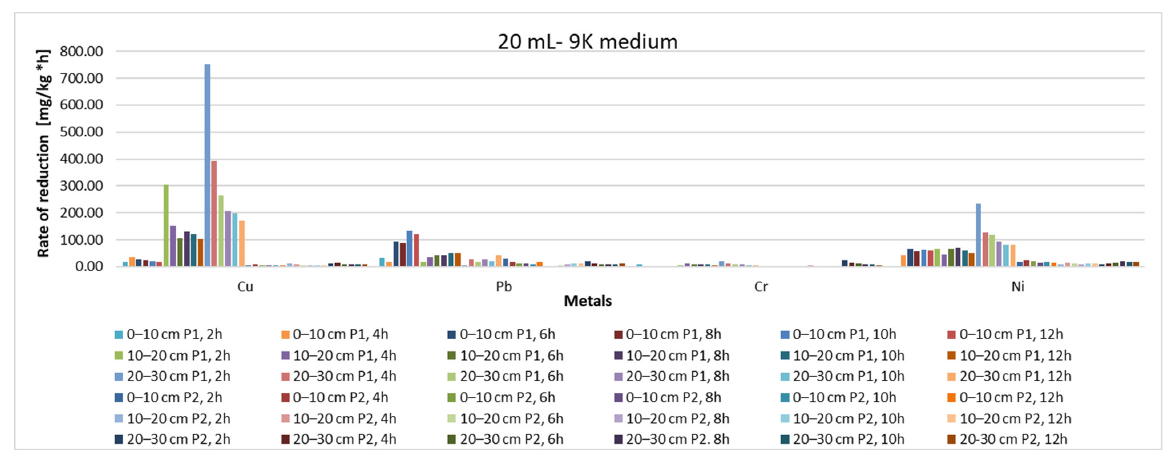
Figure 13. Reduction rate of pollutant concentration, depending on sample, sampling depth, amount of 9K medium and extraction time (20 mL 9K medium).